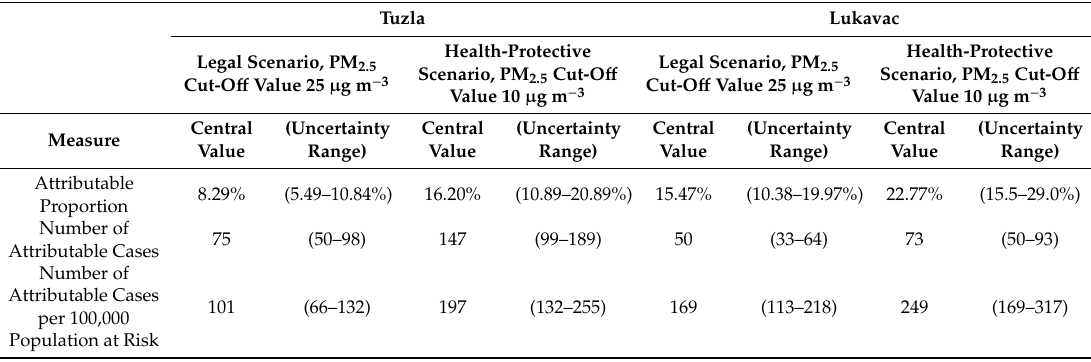
Table 3. Mortality, all (natural) causes (adults age 30 + years) attributable to PM 2.5 pollution in Tuzla and Lukavac, in legal and health-protective scenarios.